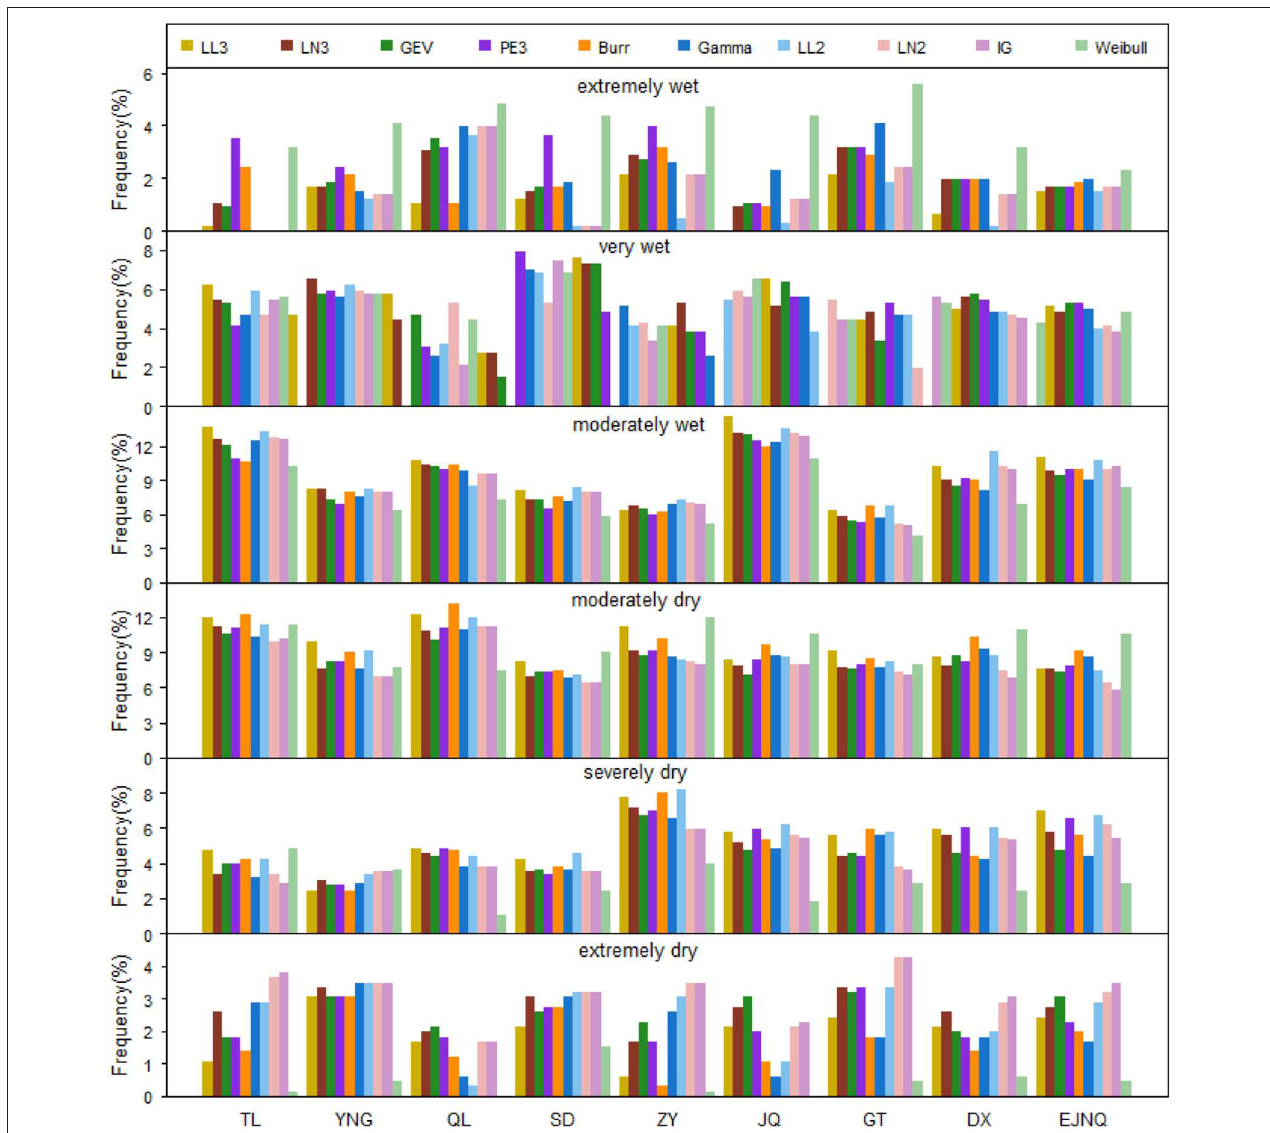
FIGURE 6 | Drought frequency of SPI modeled by different probability distributions (the abbreviations are the same as in Figure 3 ).